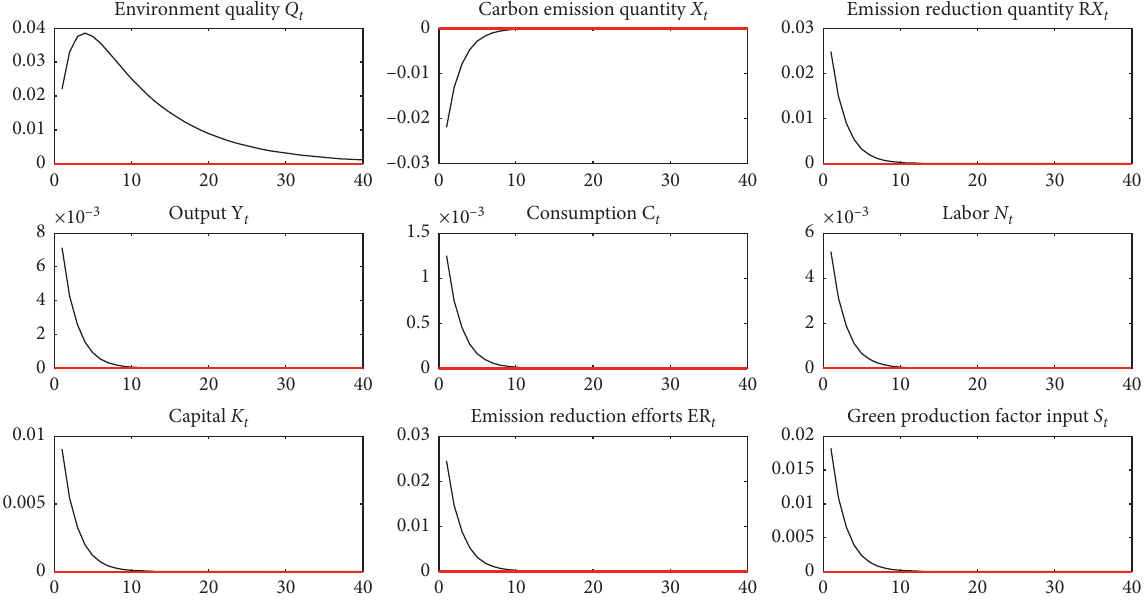
Figure 4: IRFs of carbon emission reduction subsidy rate.